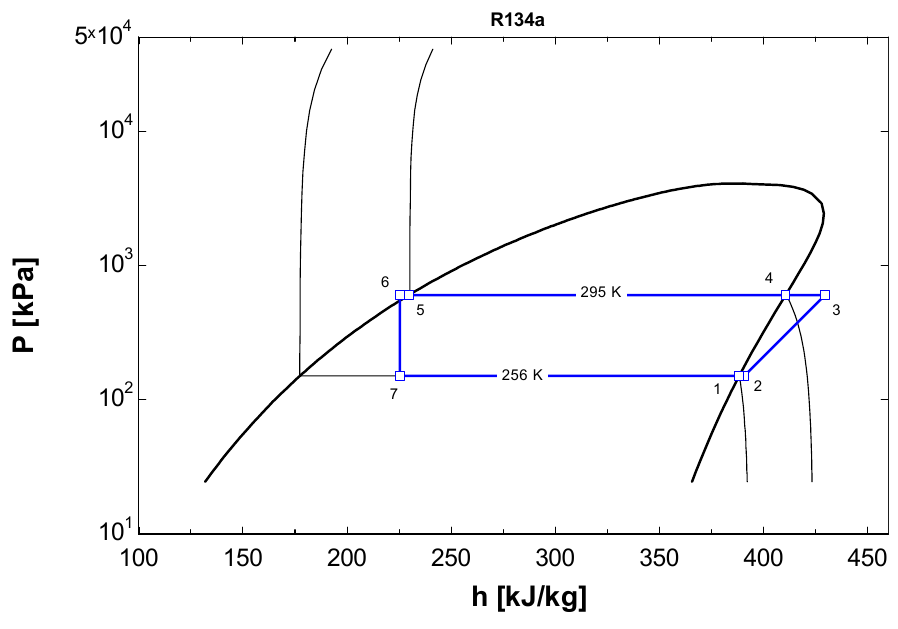
Figure 1. Vapor compression refrigeration cycle for R134a on P–h property diagram.